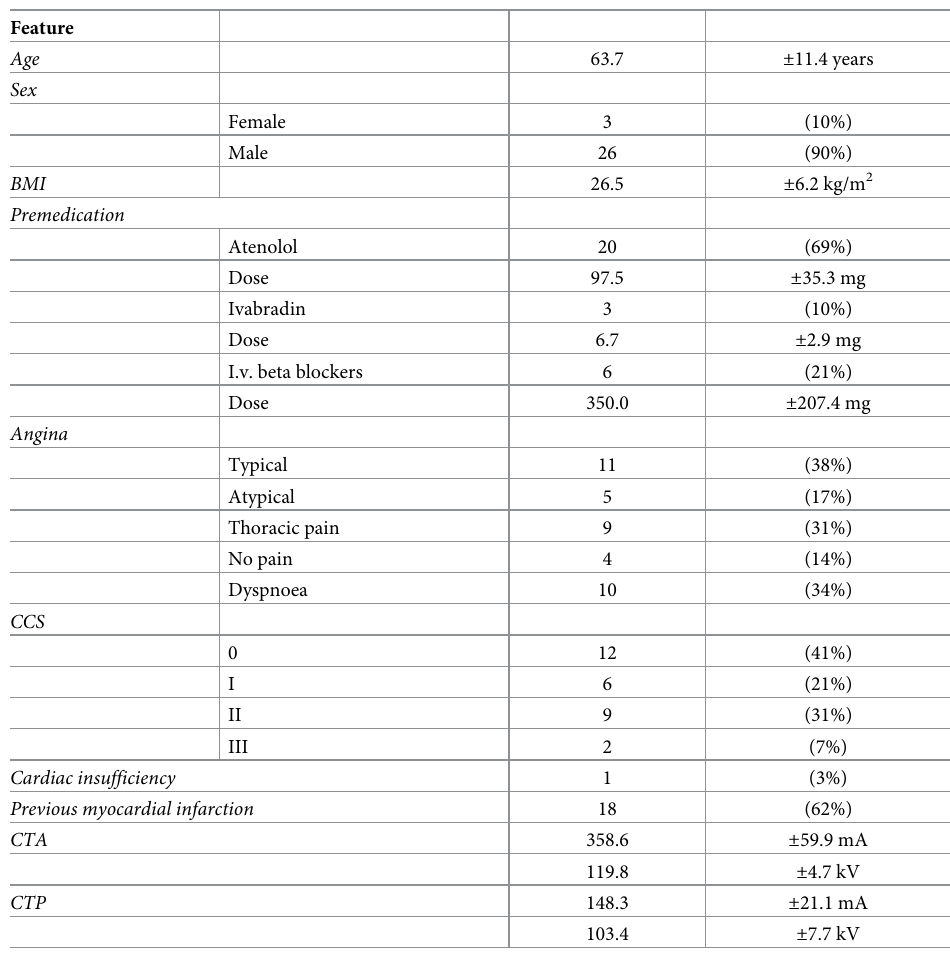
Table 1. Patient